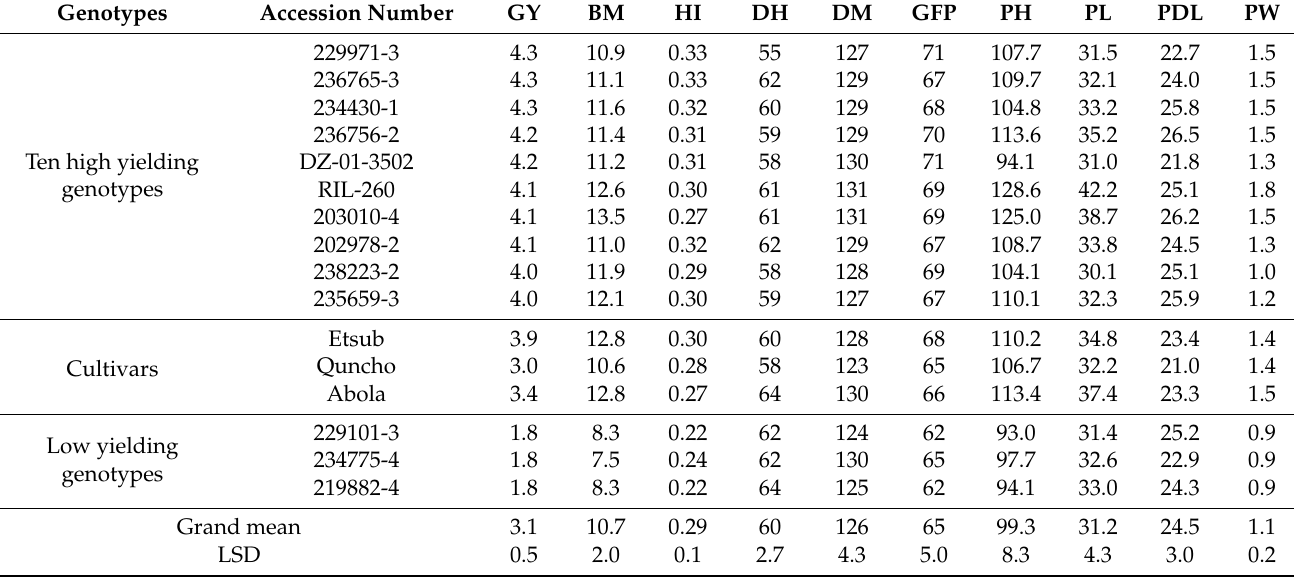
Table 2. BLUP-adjusted mean grain yield and yield related traits of the top ten high yielding, cultivars, and the bottom three low yielding teff genotypes under field growing condition with conventional management (combined over years and locations).